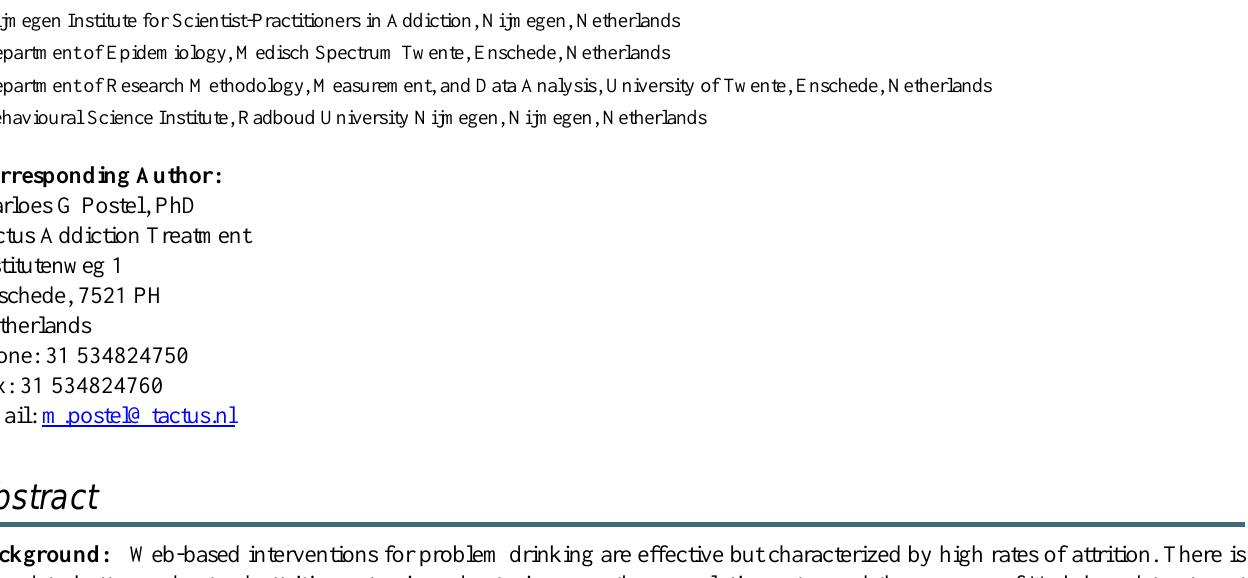
Web-based treatment; online treatment; problem drinking; alcohol; attrition;